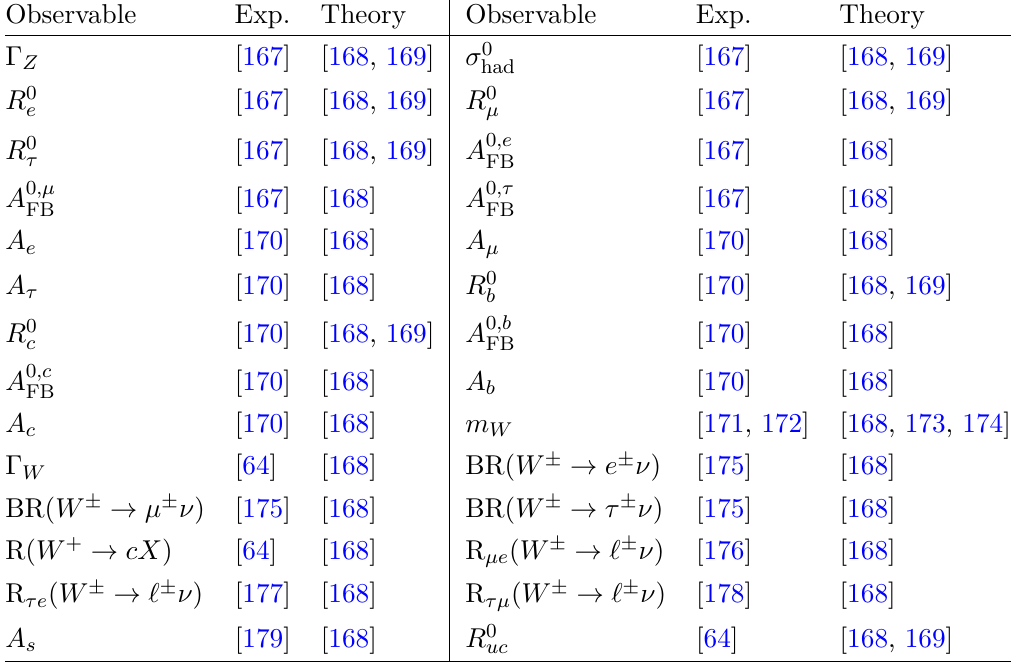
Table 10 . The EWPO observables used in smelli , along with the relevant experimental measure- ments and theory papers used in the